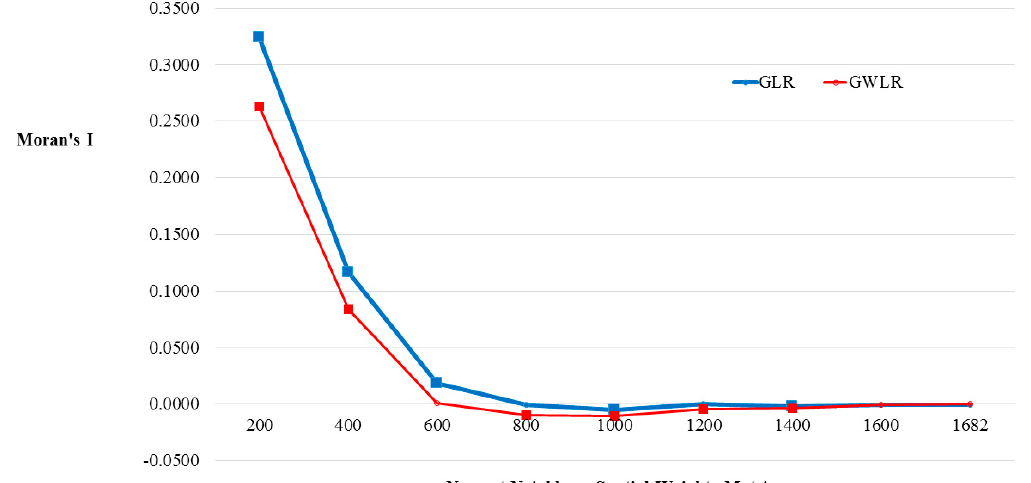
ISPRS Int. J. Geo-Inf. 2018 , 7 , x FOR PEER REVIEW Figure 9. Residuals from Map ( A ) GLR analysis and Map ( B ) GWLR analysis. Figure 9. Residuals from Map ( A ) GLR analysis and Map ( B ) GWLR analysis.